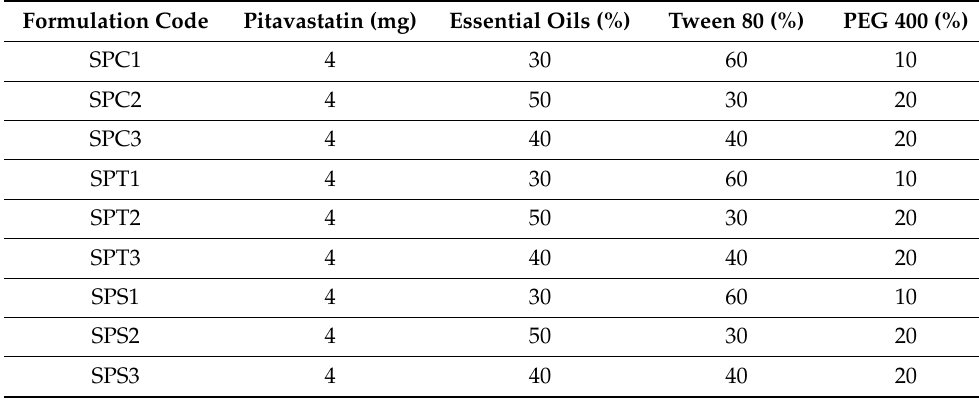
Table 1. Formulations for SNEDDS of pitavastatin. Formulation